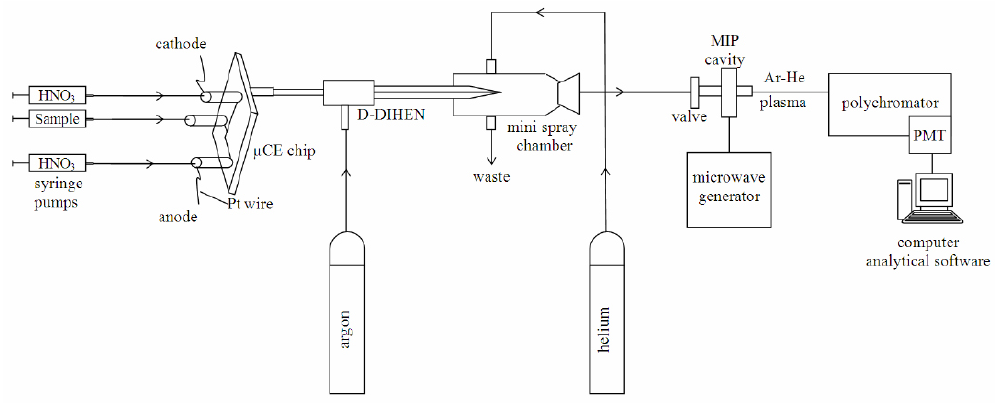
Figure 3. Component diagram of the elaborated microchip based μCE-MIP-OES system (not to scale). Table 2. Optimum operating conditions for MIP-OES measurement a of copper obtained by simplex and univariate methods.